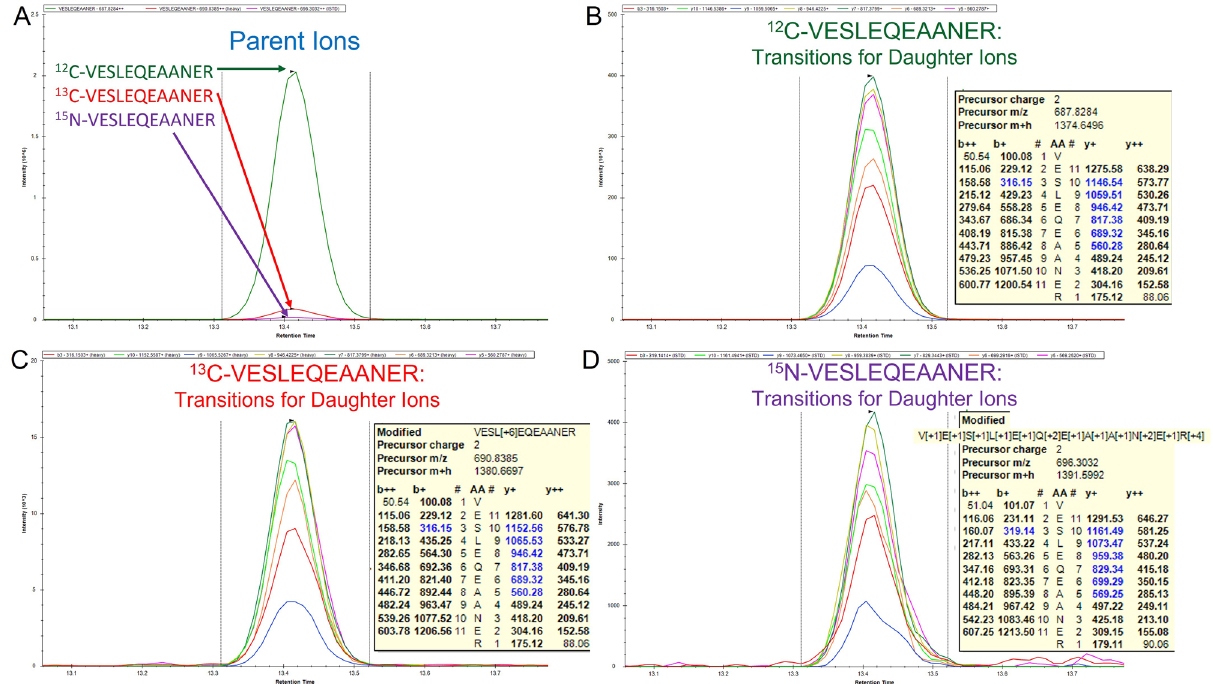
Figure 3. Parent and daughter ions of peptides measured in the SRM experiment on the TSQ Altis. ( A ) The parent ions monitored were m/z = 687.828++ ( 12 C-VESLEQEAANER), 690.838++ ( 13 C-VESLEQEAANER) and 696.3032++ ([U: 15 N]VESLEQEAANER) and elute at the identical retention time (RT). ( B ) The transitions for the 12 C-VESLEQEAANER daughter ions are shown to stack at the same RT. The inserted yellow panel shows the m/z of the b- and y-ions monitored in blue. ( C ) The transitions for the 13 C-VESLEQEAANER daughter ions are shown to stack at the same RT. The inserted yellow panel shows the m/z of the b- and y-ions monitored in blue. ( D ) The transitions for the [U: 15 N]-VESLEQEAANER daughter ions are shown to stack at the same RT. The inserted yellow panel shows the m/z of the b- and y-ions monitored in